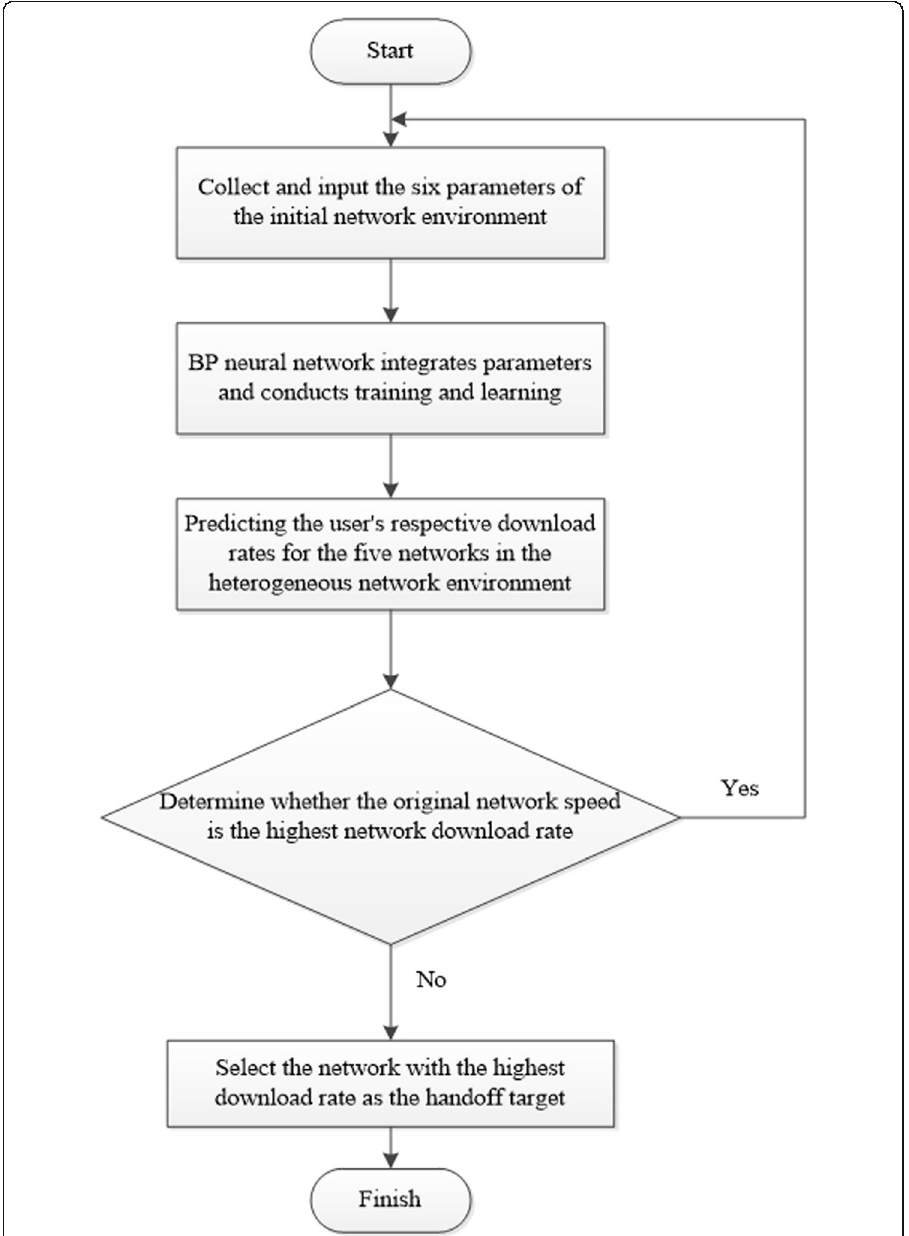
Fig. 3 Flow diagram of vertical handover in heterogeneous networks